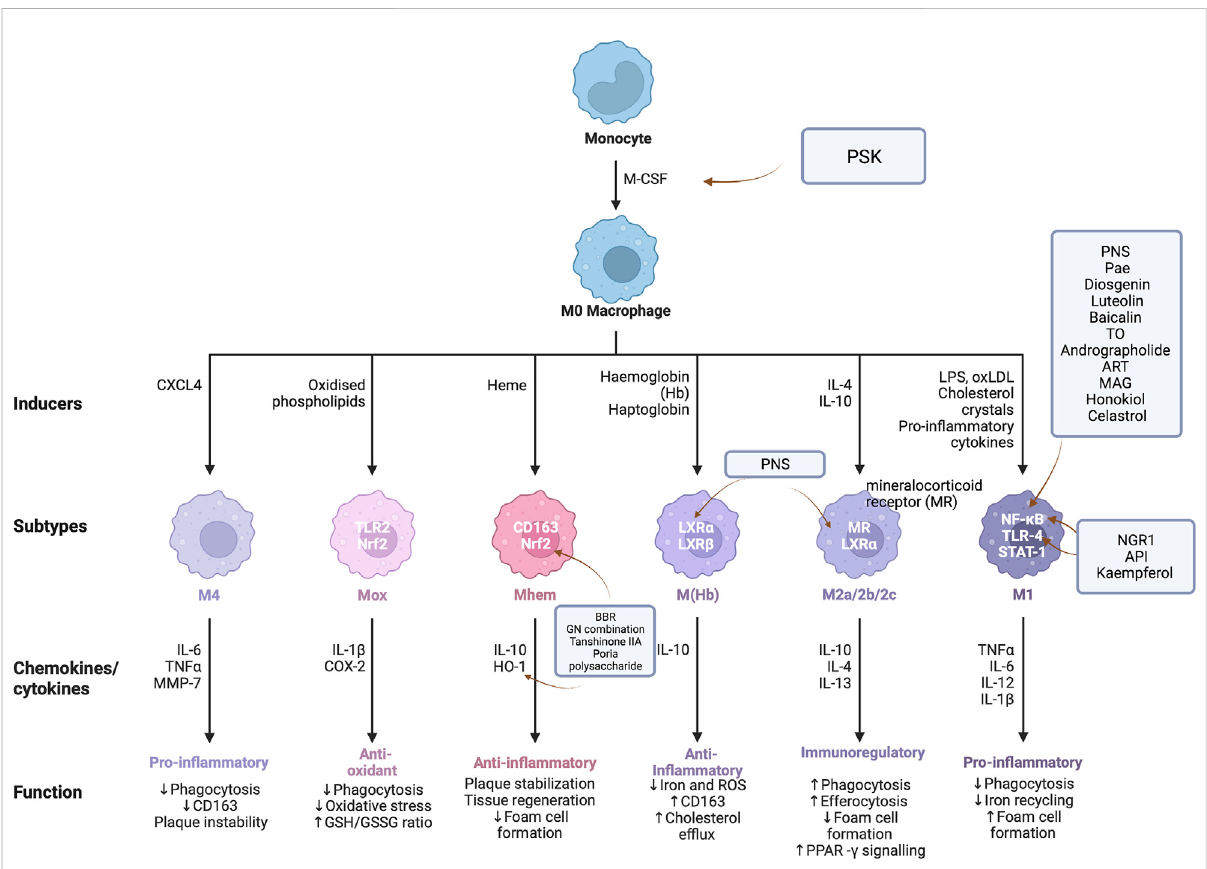
FIGURE 2 Targets/pathway of natural drugs in as in fl ammation from the perspective of in fl ammation, the preventive effect of PSK on AS is to upregulate the gene expression of M-CSF. PNS, Pae, diosgenin, luteolin, baicalin, TO, andrographolide, ART, MAG, Honoriol, Celtrol, and other drugs all participateintheinhibitionofNF- κ Bsignalpathwayforregulatingin fl ammationofatherosclerosis,whileNGR1,API,andkaempferolcouldinhibitthe TLR4/NF- κ B signal pathway. BBR, GN combination, tanshinone IIA, and Poria cocos polysaccharide could reduce in fl ammatory damage by activating Nrf2/HO-1 signal